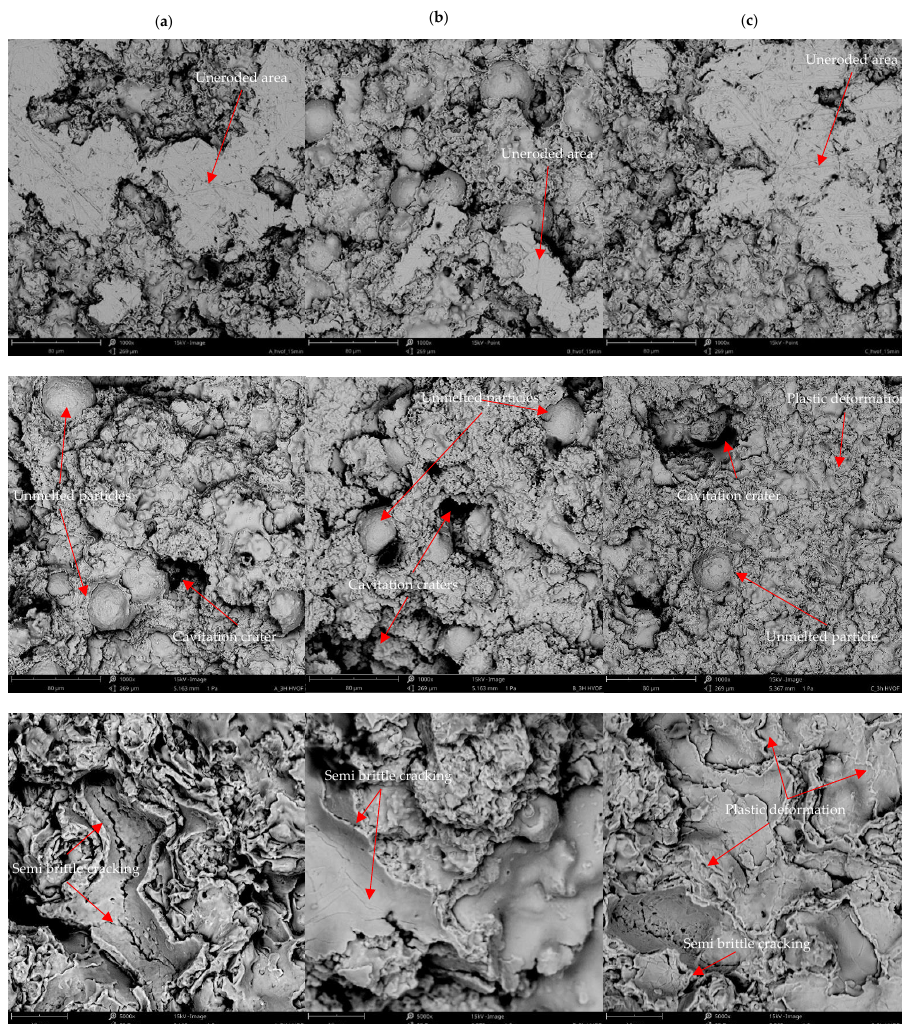
Figure 13. Effect of hardness ( a ) and material loss ( b ) on eroded surface roughness, 3 h of exposure.